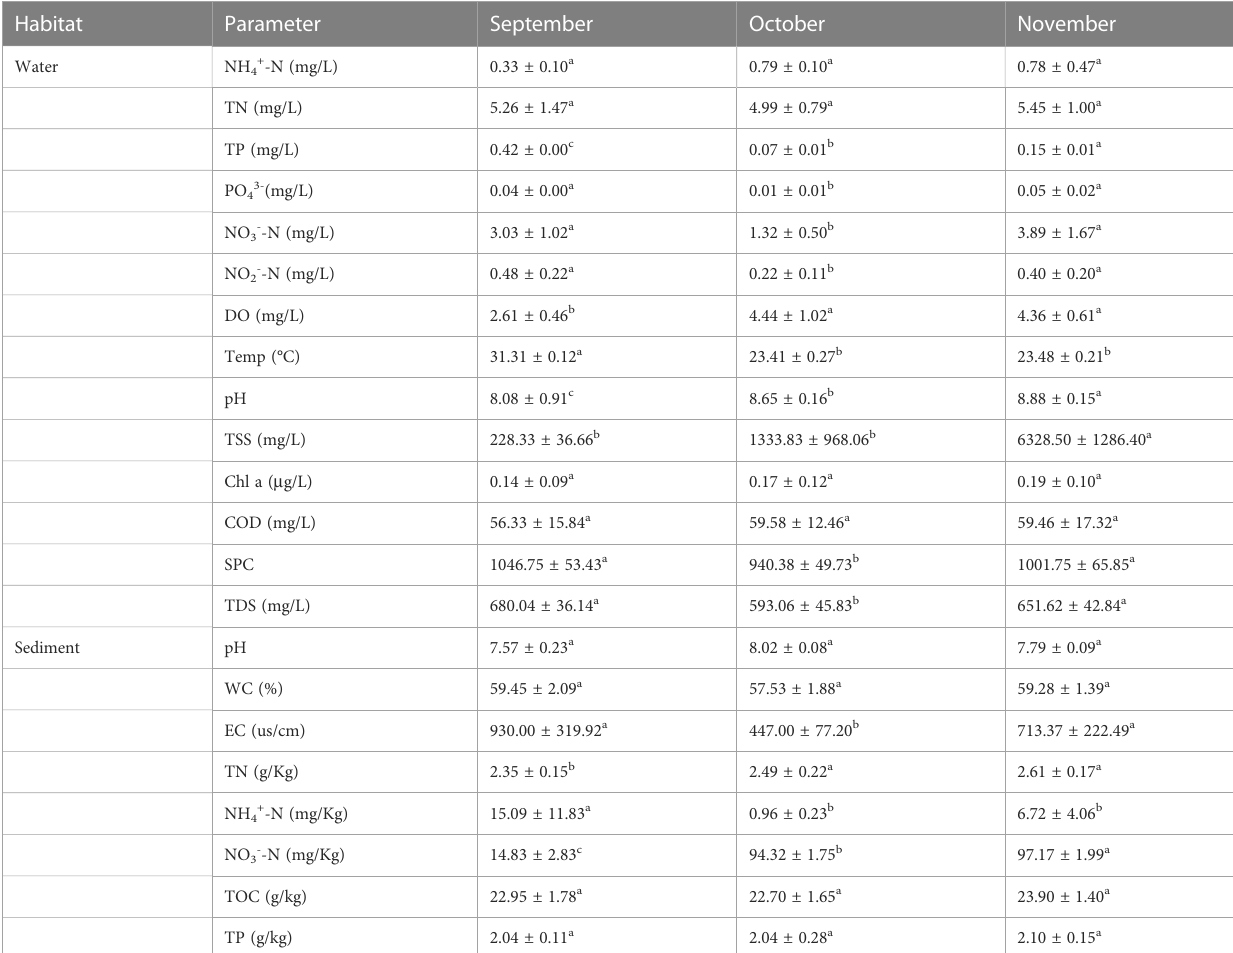
TABLE 1 Water and sediment physicochemical factors in different months.